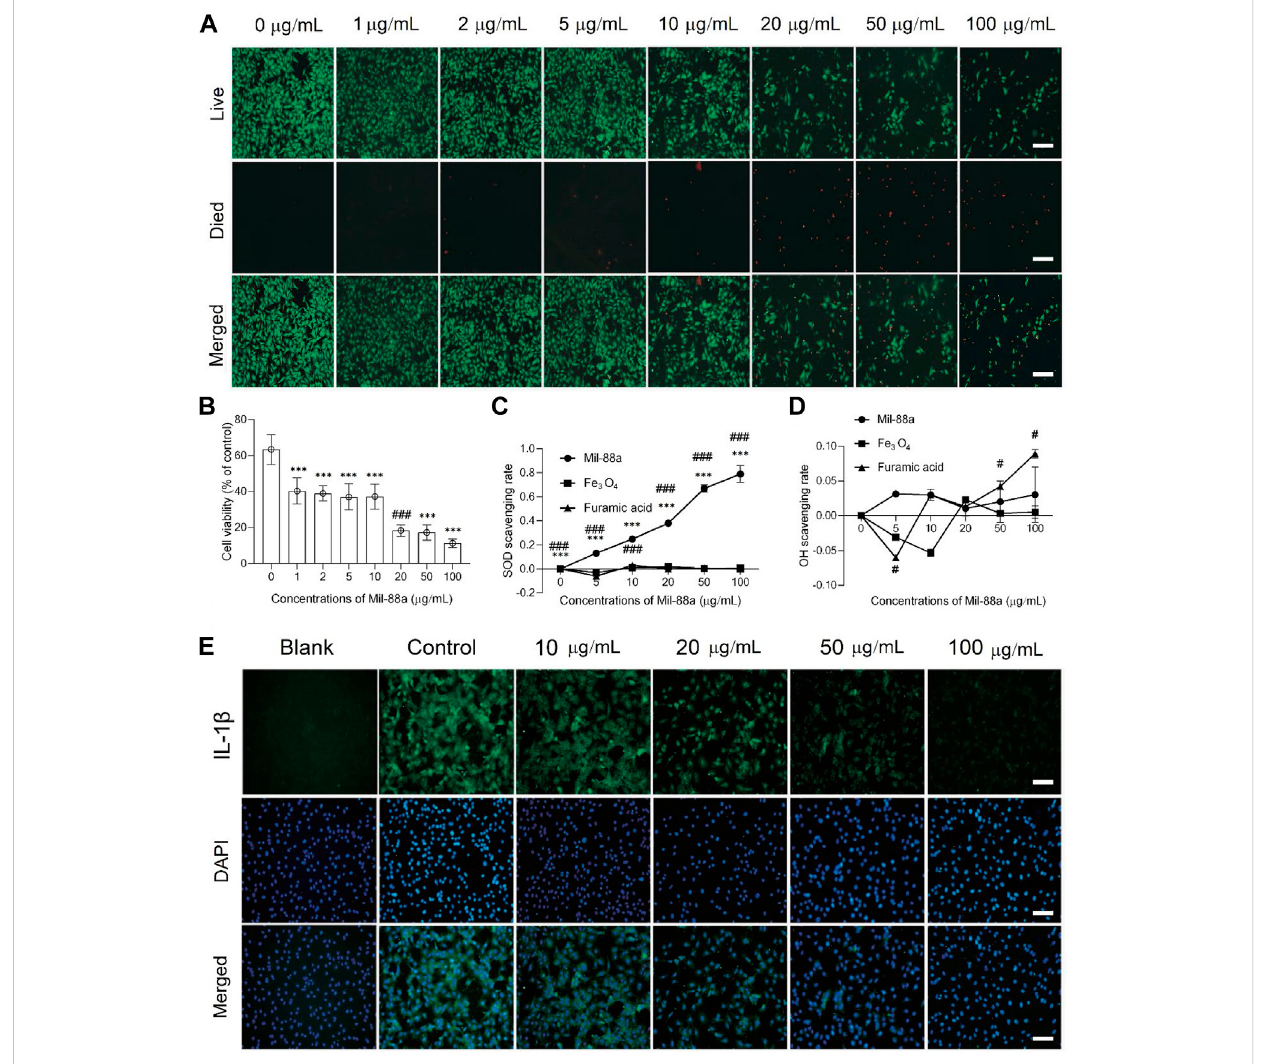
FIGURE 2 Cytotoxicity and biocompatibility testing of Mil-88a in vitro . (A) Fluorescence microscopy images of calcein-AM/PI staining in cells treated with different concentrations of Mil-88a (1, 2, 5, 10, 20, 50, and 100 μ g/mL). Live, live cells (green); died, dead cells (red); merge, overlay. (B) Cell viabilities of chondrocytecellstreatedwithdifferentconcentrationsofMil-88a(1,2,5,10,20,50,and100 μ g/mLand n =4).Theeffectsofdifferentconcentrationsof Mil-88a (1, 2, 5, 10, 20, 50, and 100 μ g/mL and n = 4) on SOD- (C) and OH- (D) scavenging rates for 24 h, and IL-1 β (E) . *** p < 0.001 compared with 0 μ g/mL; ### p < 0.001 compared with 10 μ g/mL. Scale bar = 100 μ